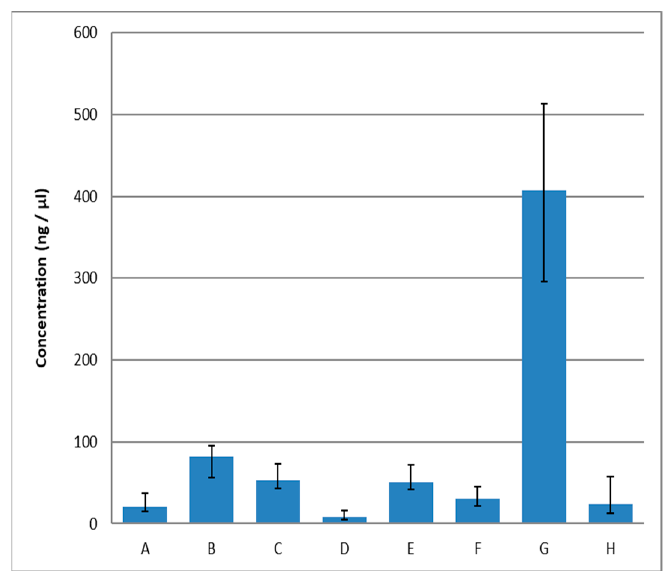
Figure 1. The average DNA concentrations obtained using the selected extraction methods A–H; A—DNeasy Blood and Tissue Kit (Qiagen), B—DNeasy mericon Food Kit (Qiagen), C—Chemagic DNA Tissue 10 Kit (PerkinElmer), D—Food DNA Isolation Kit (Norgen Biotek), E—UltraPrep Genomic DNA Food Mini Prep Kit (AHN-Bio), F—High Pure PCR Template Preparation Kit (Roche), G—phenol-chloroform extraction, H—NucleoSpin Food (Macherey-Nagel).